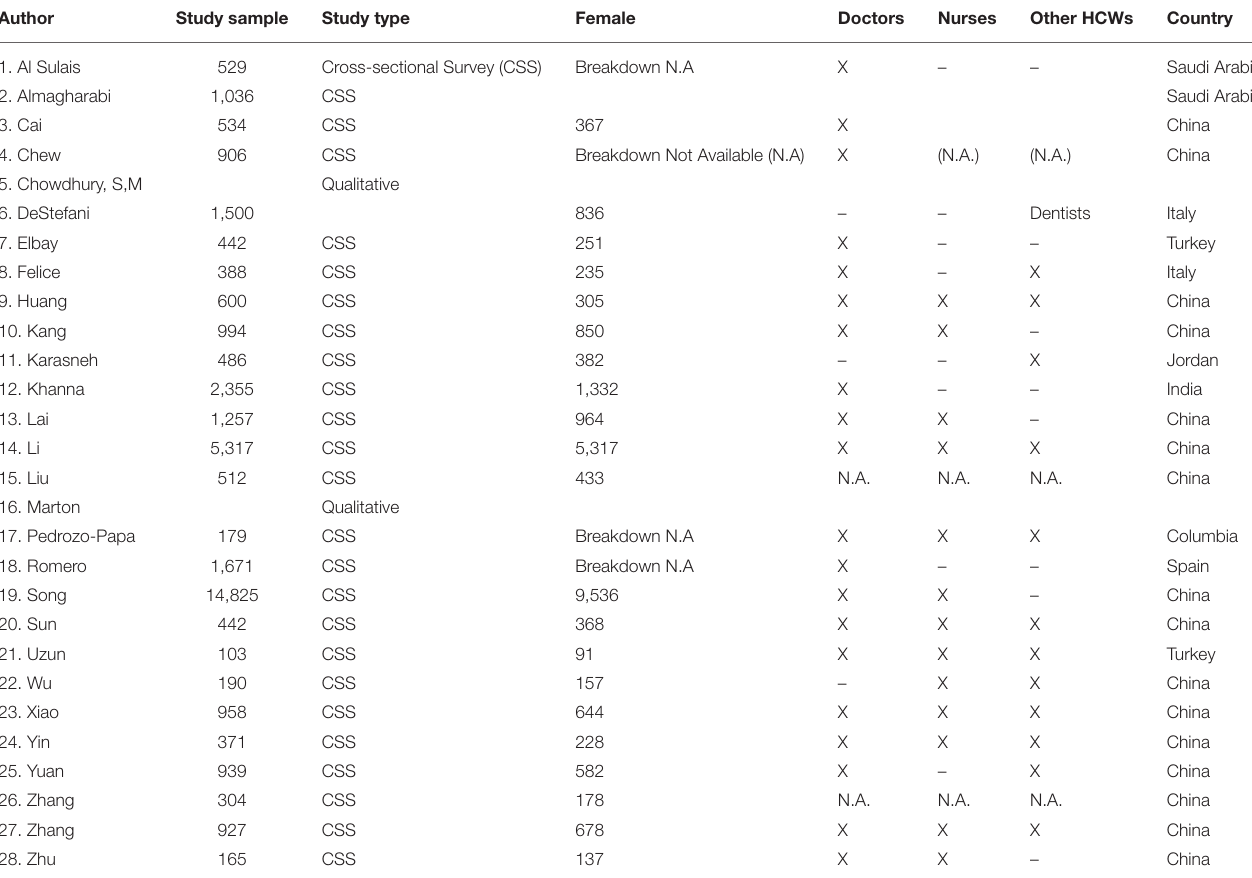
TABLE 1 | Summary of primary